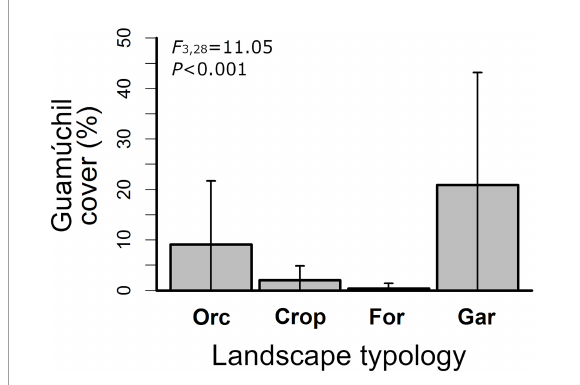
FIGURE1 Variation of Guamúchil cover among the typologies of the cultural landscape of Zacualpan, Colima, Mexico. Orc, Hog plum orchards; Crop, cropfields; For, tropical dry forest; Gar, homegardens.